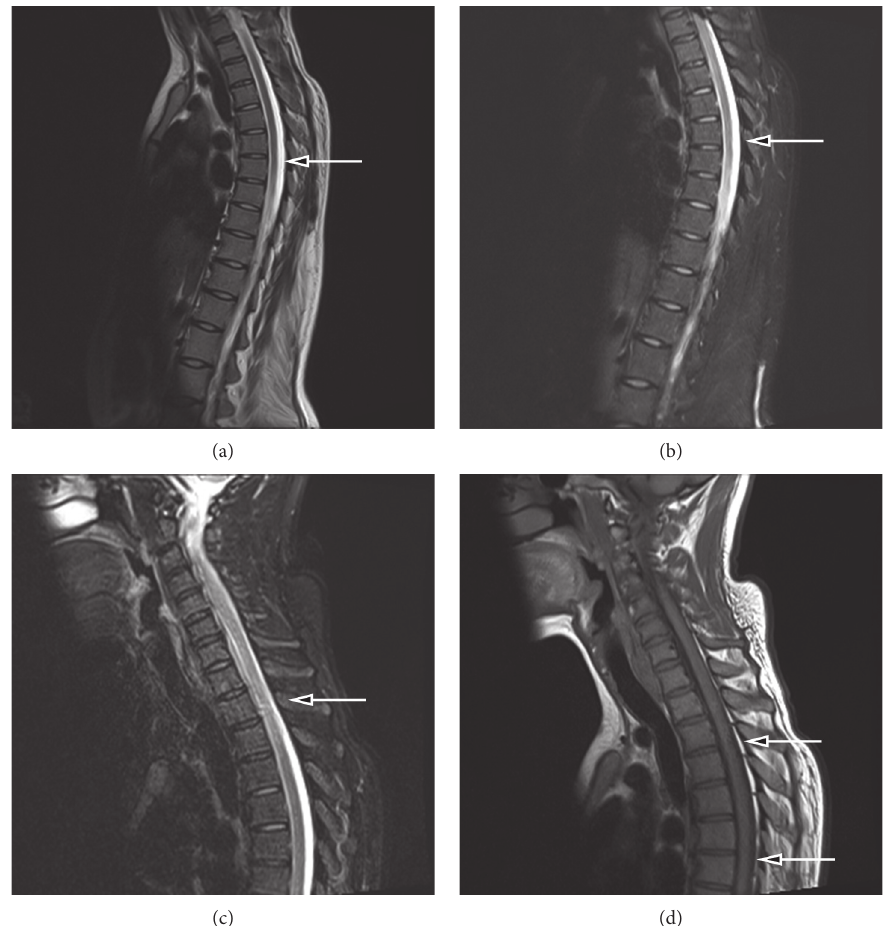
Figure 1: Magnetic resonance imaging (MRI) of the thoracic spinal cord. The gray arrow indicates the site of the thoracic spinal cord was smaller than the healthy